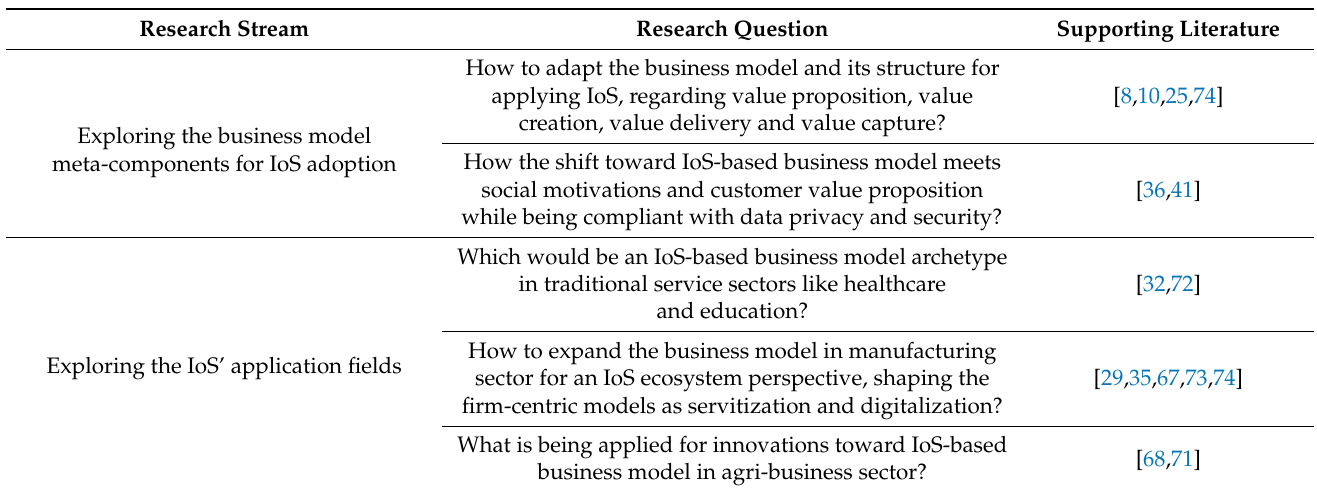
Table 6. Research